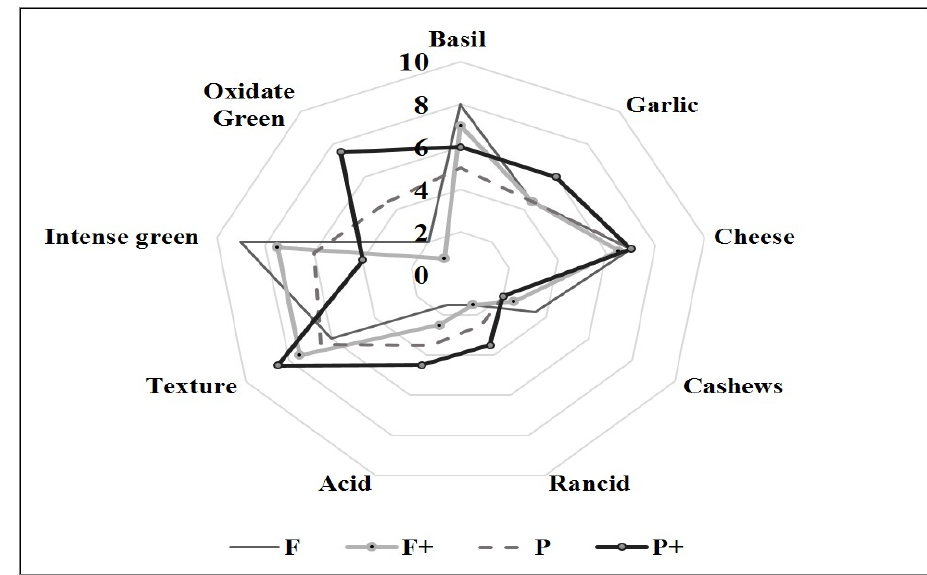
Figure 5. Sensorial evaluation of basil pesto at 1st time of storage.